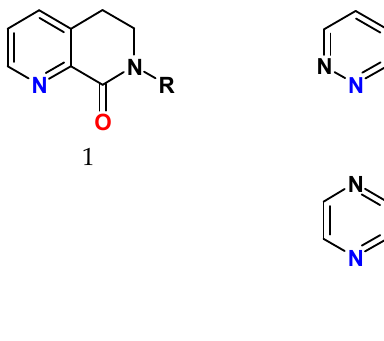
Table 1. Calculated extraction energies (ΔG ext ) and predicted selectivities of ligands in the separa- tion of Am(III) and Eu(III) (ΔΔGext(Am-Eu)) by solvent extraction into kerosene. Reprinted with permission from ref. [157]. Copyright 2015 Royal Society of Chemistry.